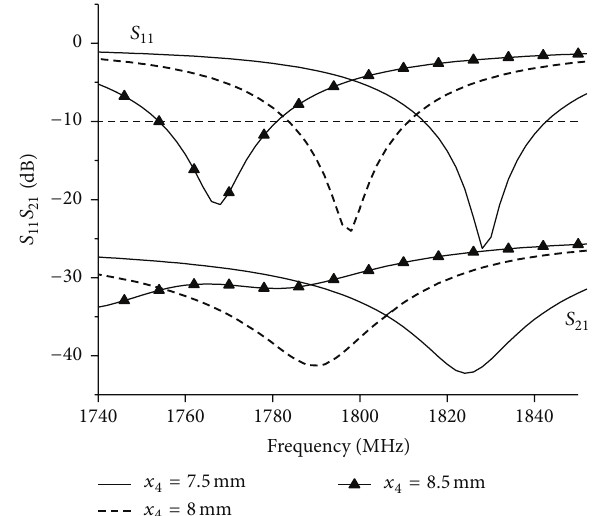
Figure 2: Simulated 𝑆 11 and 𝑆 21 with different values of 𝑥 4